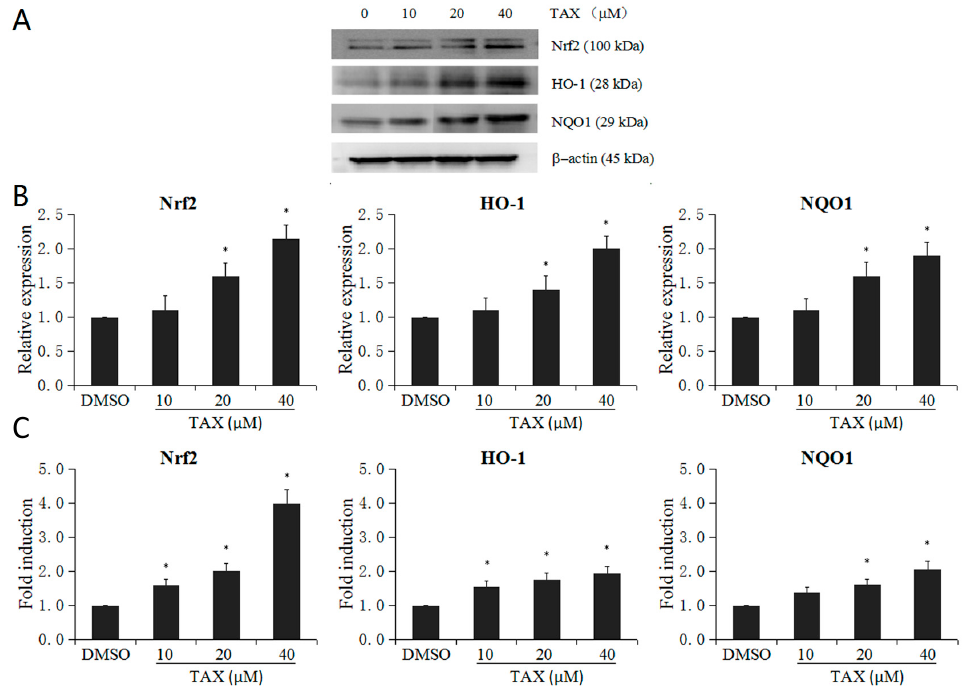
Figure 5. Effect of TAX on mRNA and protein expression of Nrf2 and Nrf2 target genes (HO-1 and NQO1) in JB6 P+ cells. JB6 P+ cells were treated with different TAX concentration (10 to 40 µ M). ( A ) Western blot images of Nrf2 and its downstream genes including HO-1 and NQO1; ( B ) TAX increased the protein expression of Nrf2 and Nrf2 downstream enzymes; ( C ) TAX increased the mRNA levels of Nrf2 and its downstream representative enzymes including HO-1 and NQO1. The graphical data are presented as the mean ± SD from three independent experiments. * p < 0.05, indicating significant differences in each target protein or mRNA compared with its level in non-TAX-treated